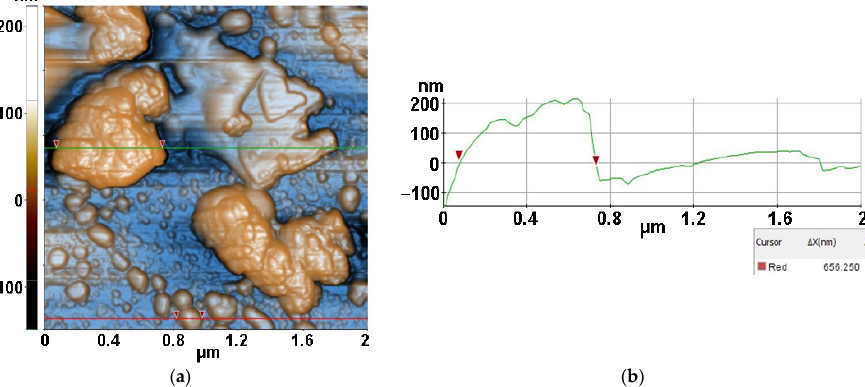
Figure 13. Two-dimensional AFM images of S. aureus (from inoculum) with ZnSe deposited on glass substrate, after 30 min of irradiation, recorded at the scale of (2 μ m × 2 μ m) ( a ), with a characteristic surface profile ( b ).